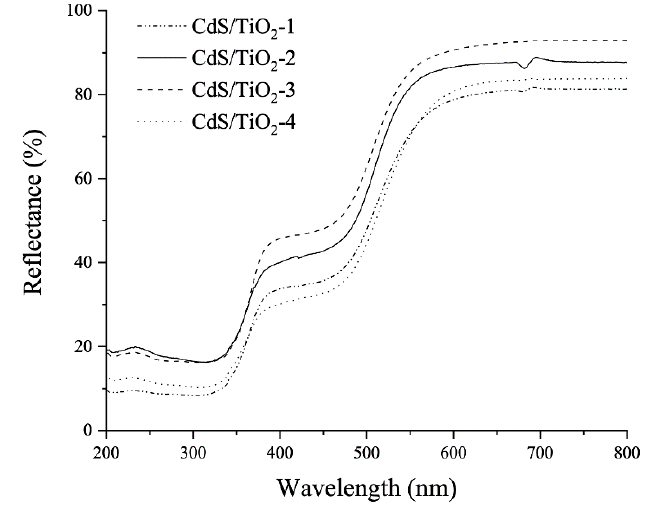
Figure 3. UV-vis DR spectra of CdS/TiO 2 -(1 – 4) materials.